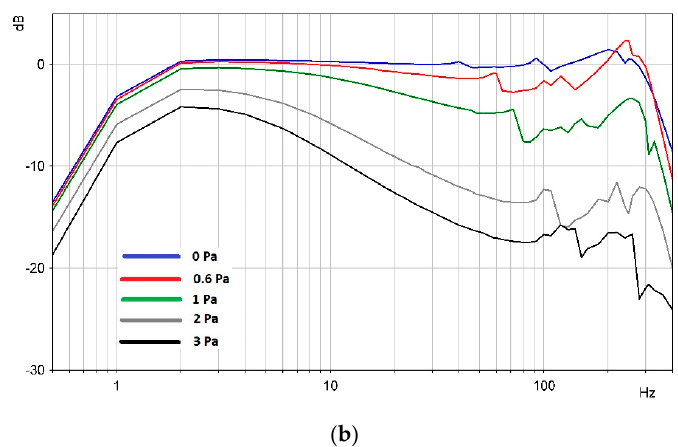
Figure 4. Frequency response curves (0.8 mV/Pa) of the MET hydrophones under different pressure differences. ( a ) With the volume completely filled with liquid under the upper cover; ( b ) with the partially filled volume.